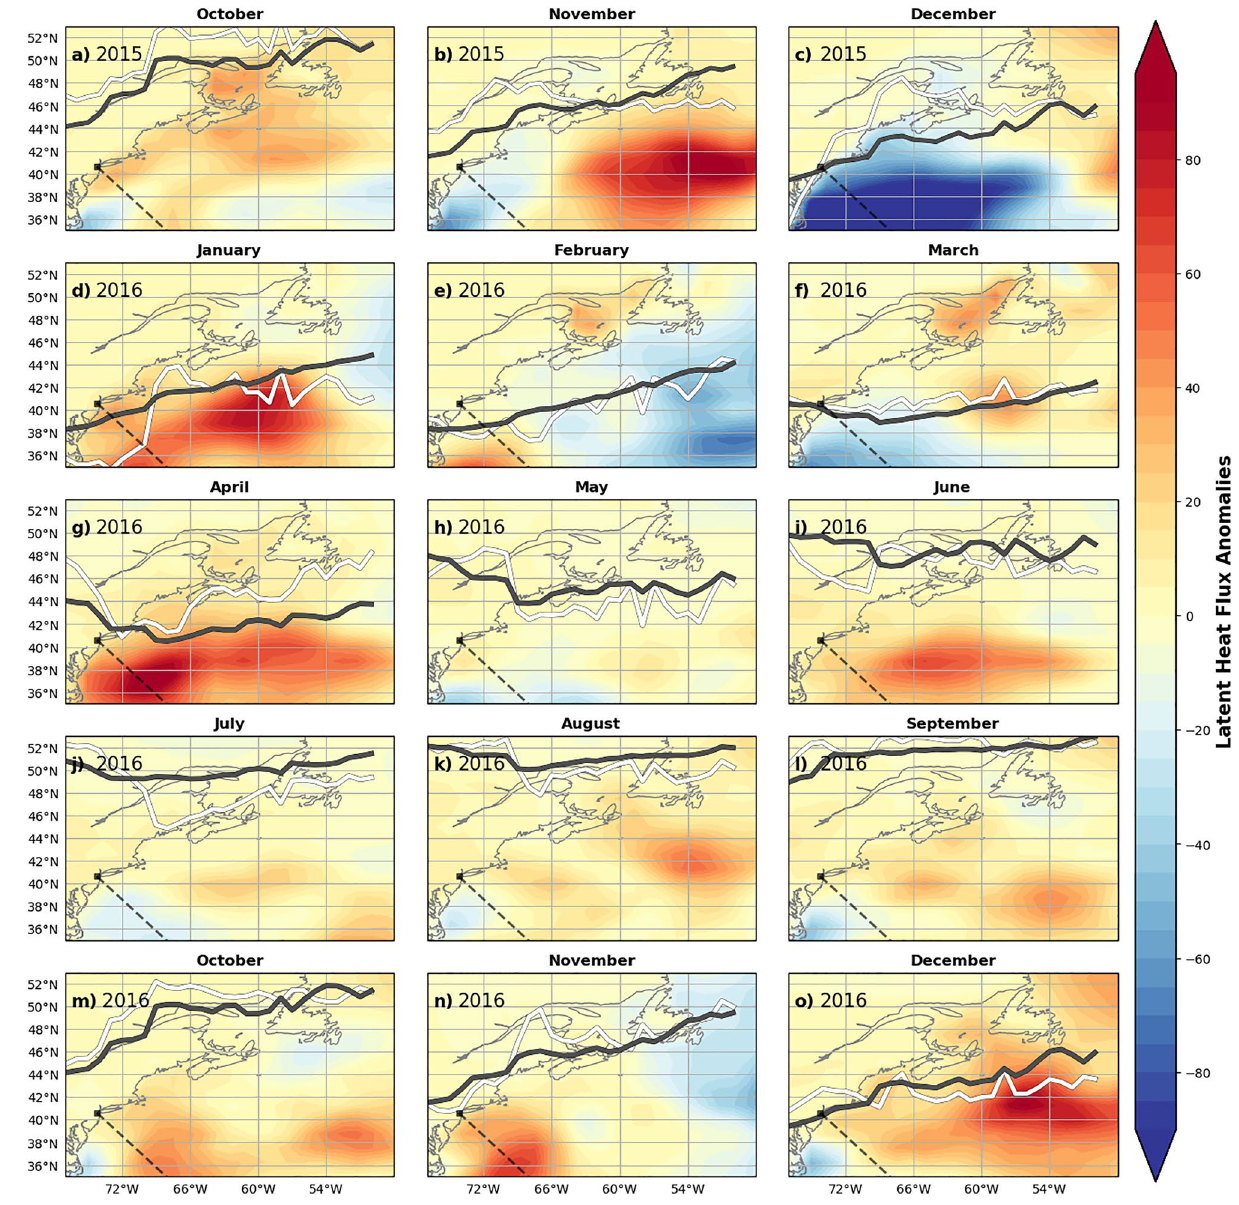
Figure 6. Latent heat flux anomaly for the 2015/16 period. Negative (positive) anomalies indicate the ocean is gaining (losing) more heat than usual for the 1986–2016 period. The thick gray line is the climatological position of the jet stream (1986–2016). The thick white line is the jet stream’s latitudinal position for 2015/16. These maps were generated using Python version